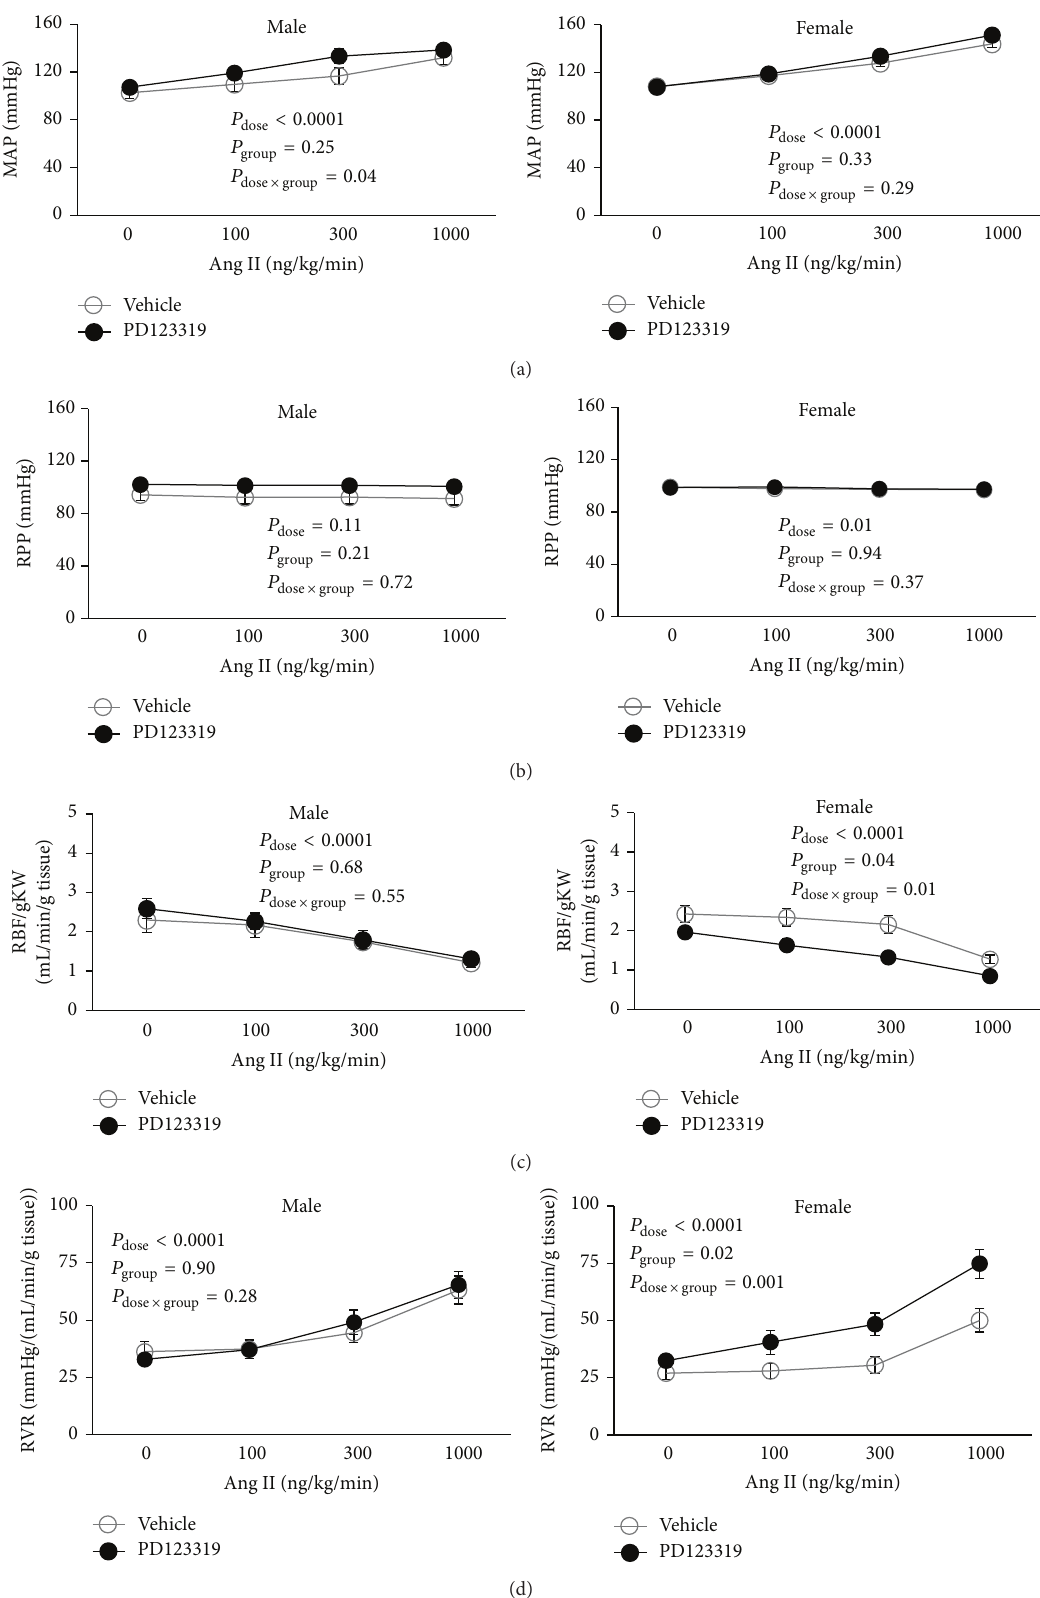
Figure 2: MAP, RPP, RBF, and RVR responses to Ang II administration which started to infuse 30 min after reperfusion. Data are shown as mean ± SEM. MAP, mean arterial pressure; RPP, renal perfusion pressure; RVR, renal vascular resistance; RBF, renal blood flow. 𝑃 values were derived from repeated measures